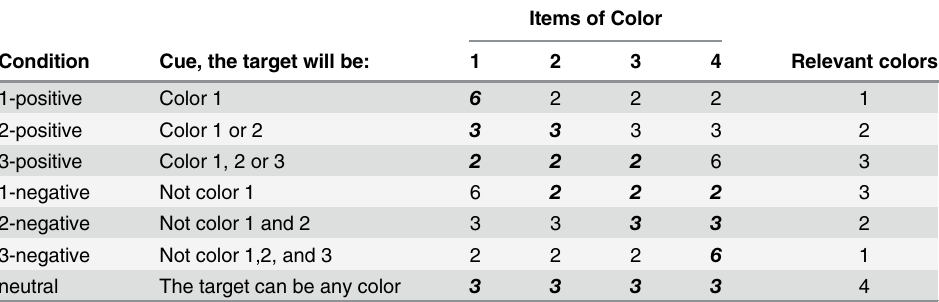
Table 1. Conditions in experiment 2.